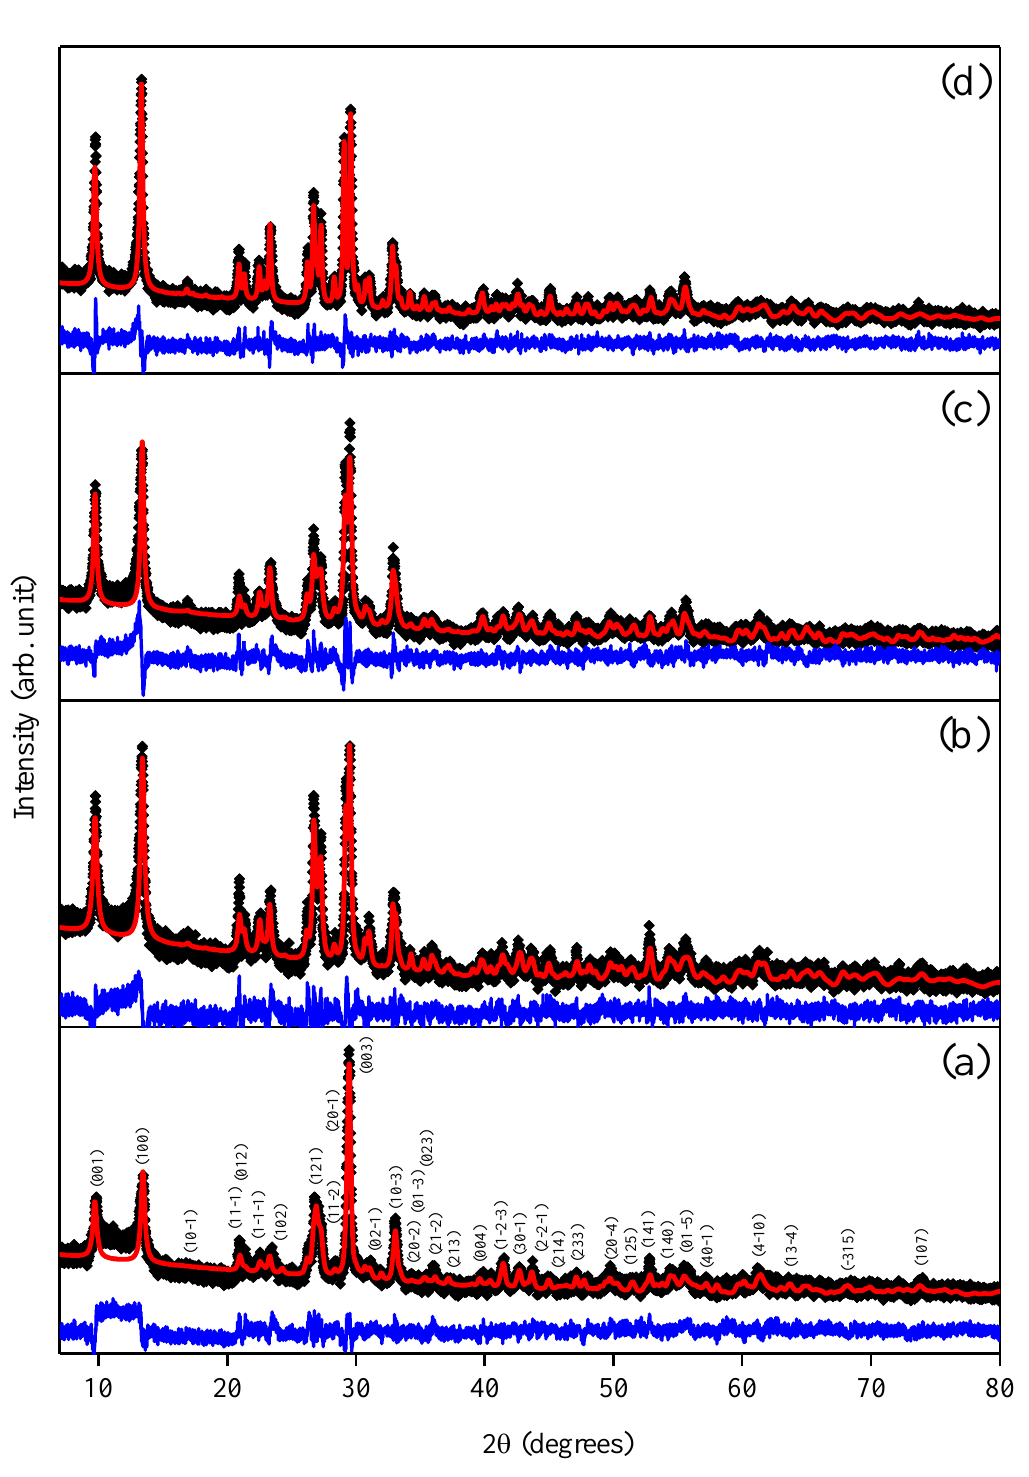
Figure 1. Rietveld refinement profiles for as prepared for ( a ) pure CoMoO 4 · nH 2 O and Co 1 − x Cu x MoO 4 · nH 2 O with x equals to ( b ) 0.03, ( c ) 0.06, and ( d ) 0.12.